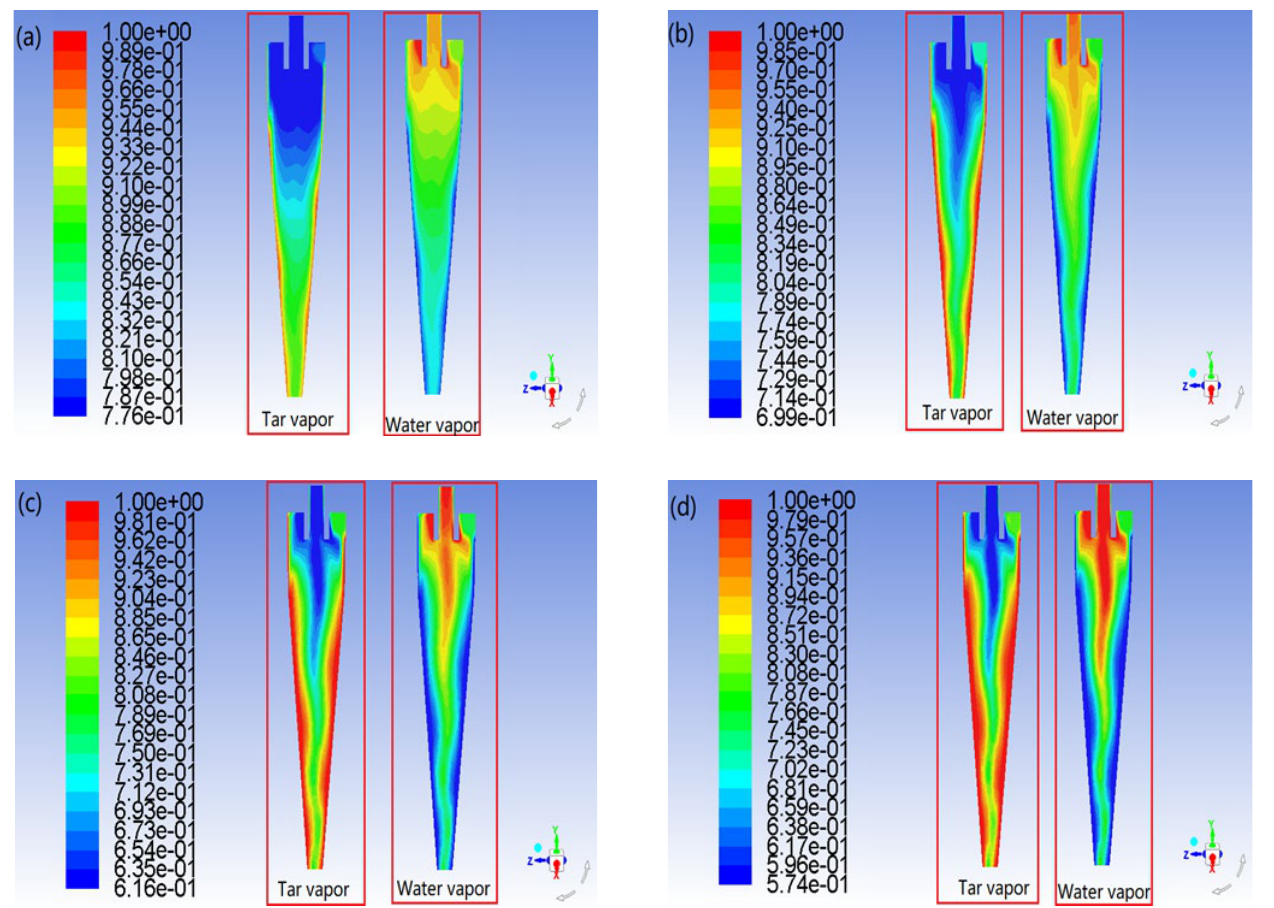
Figure 5. The phase distribution of tar vapor and water vapor in cyclone section with water content of 20%. ( a ) Inlet velocity 2.0 m/s, ( b ) inlet velocity 4.0 m/s, ( c ) inlet velocity 8.0 m/s, and ( d ) inlet velocity 12.0 m/s.